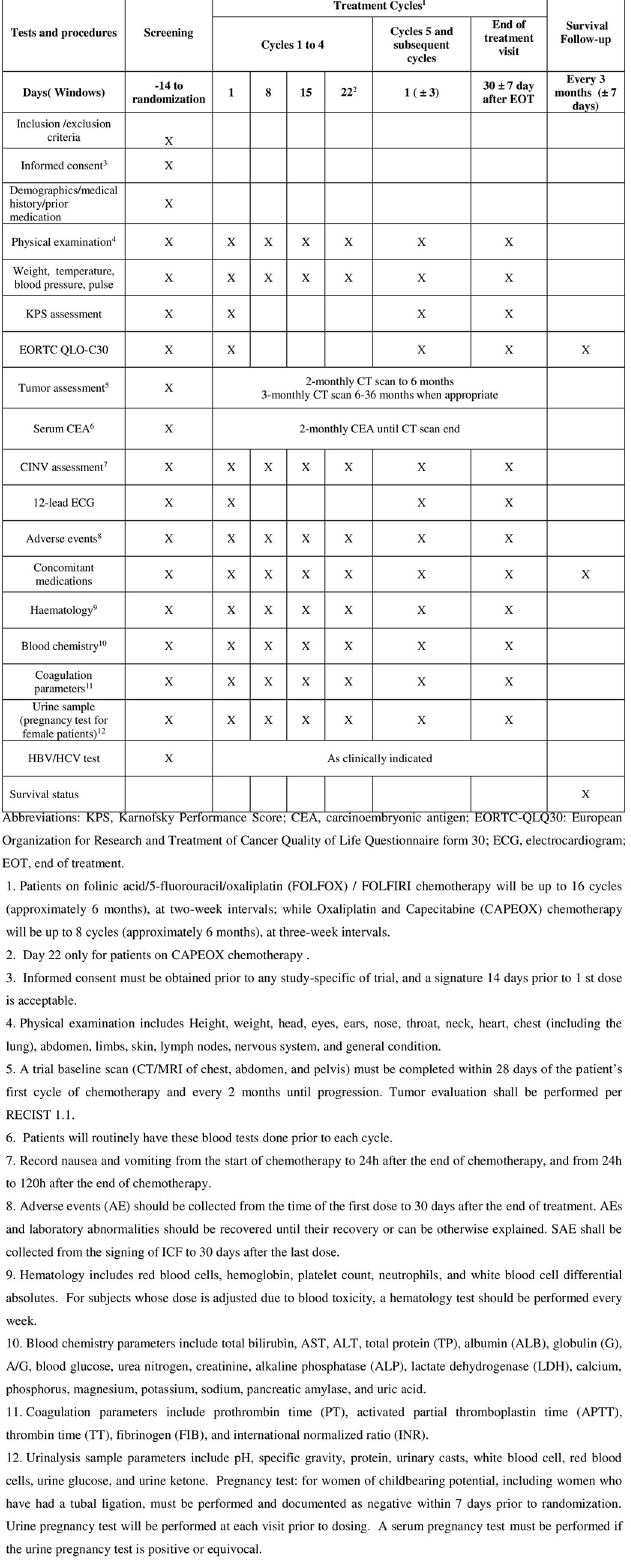
Fig 1. SPIRIT schedule of tests and